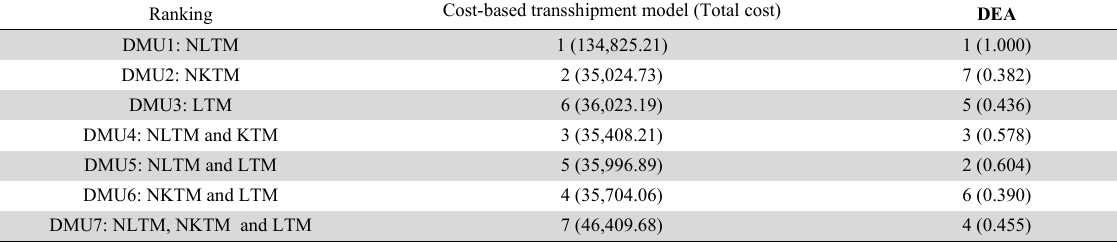
Comparison of the cost-based model and proposed DEA Ranking Cost-based transshipment model (Total cost)